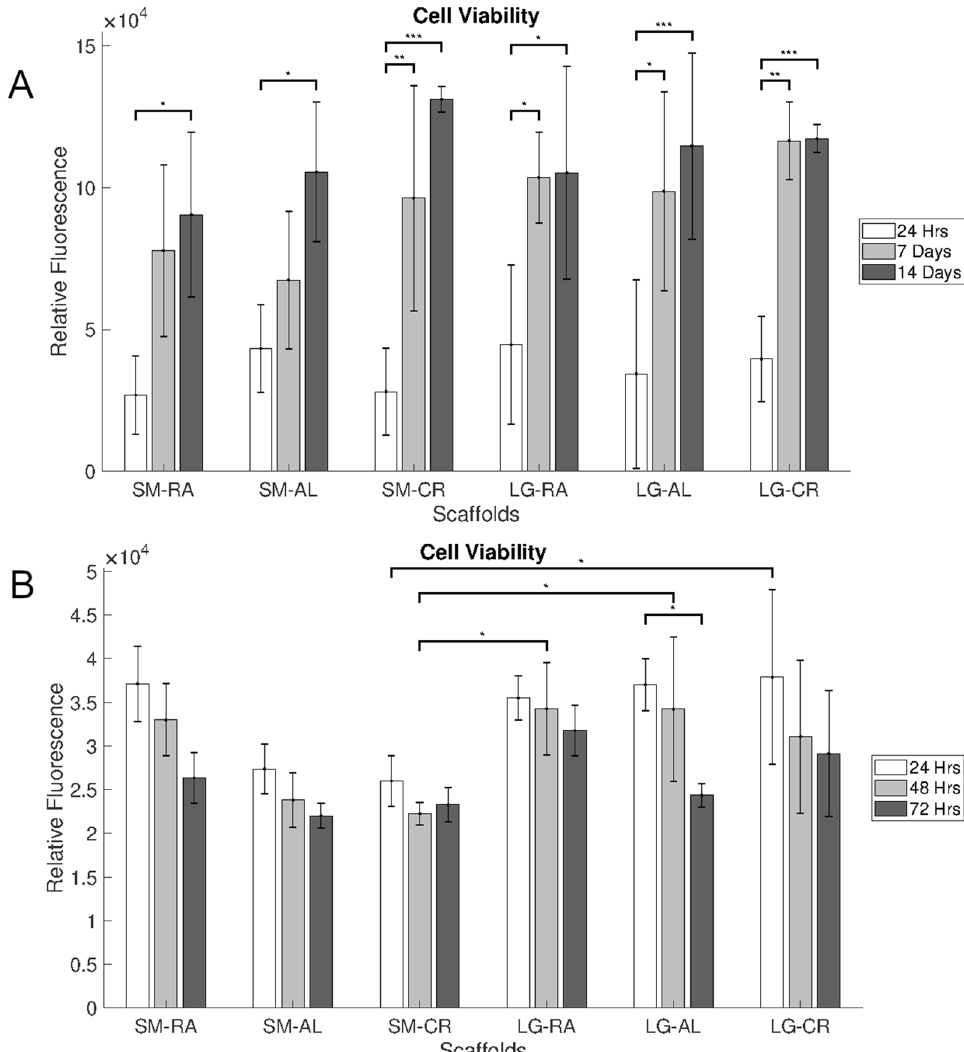
Figure 3. Cell titre blue fluorescence results for ( A ) hepg2 over 14 days and ( B ) MPHs over 3 days. N = 5, Error bars = SD and *p < 0.05, **p < 0.01 and ***p <